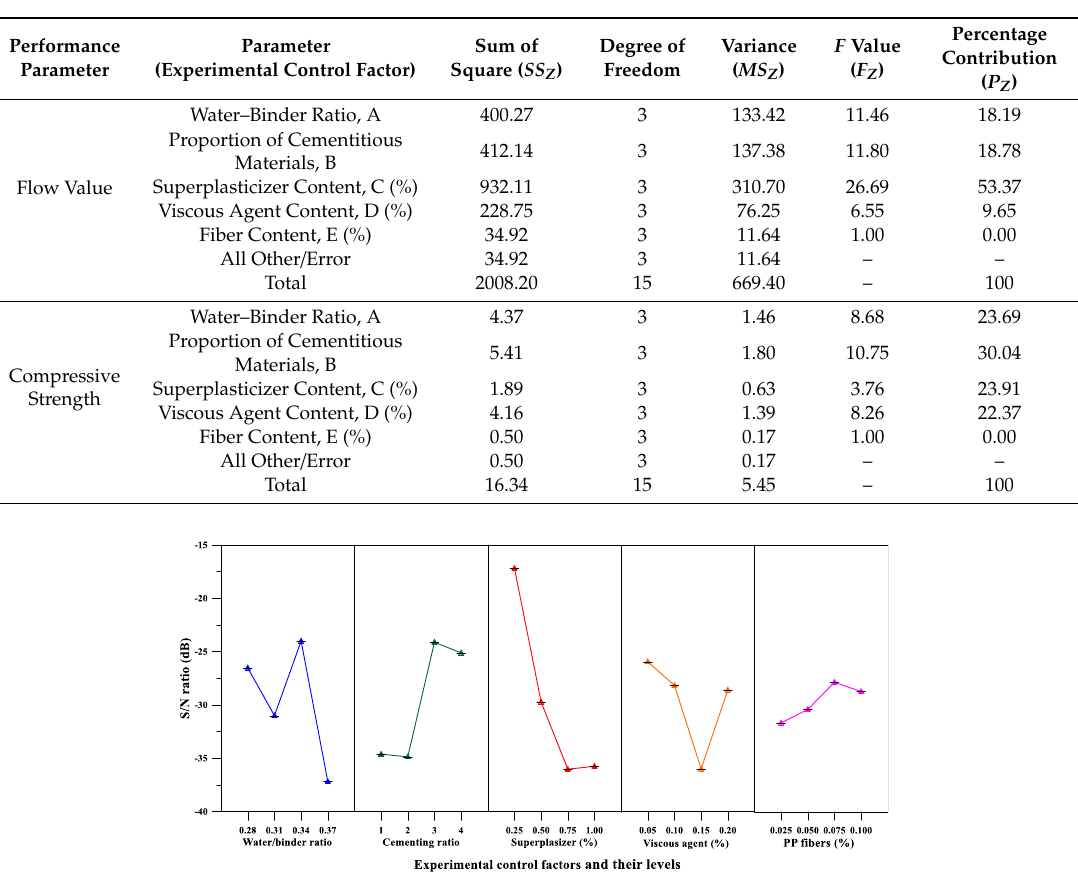
Table 11. Variance analysis and F test for matrixes.